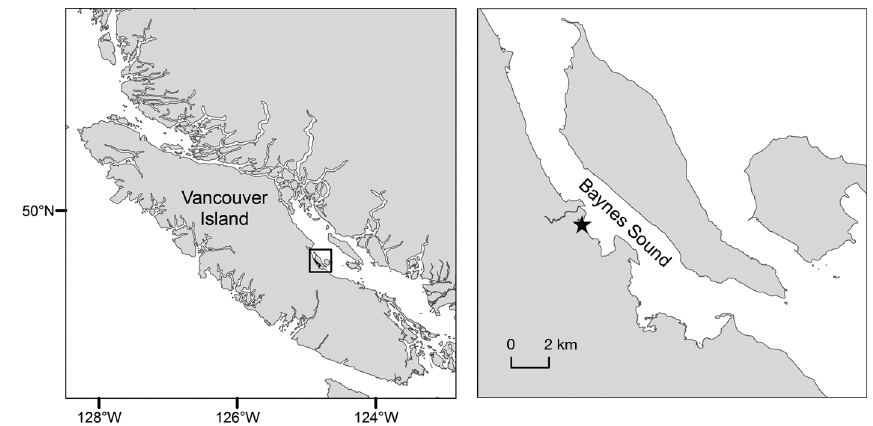
Fig. 1. Location of study site ( Q ) in Fanny Bay on Vancouver Island, British Columbia,